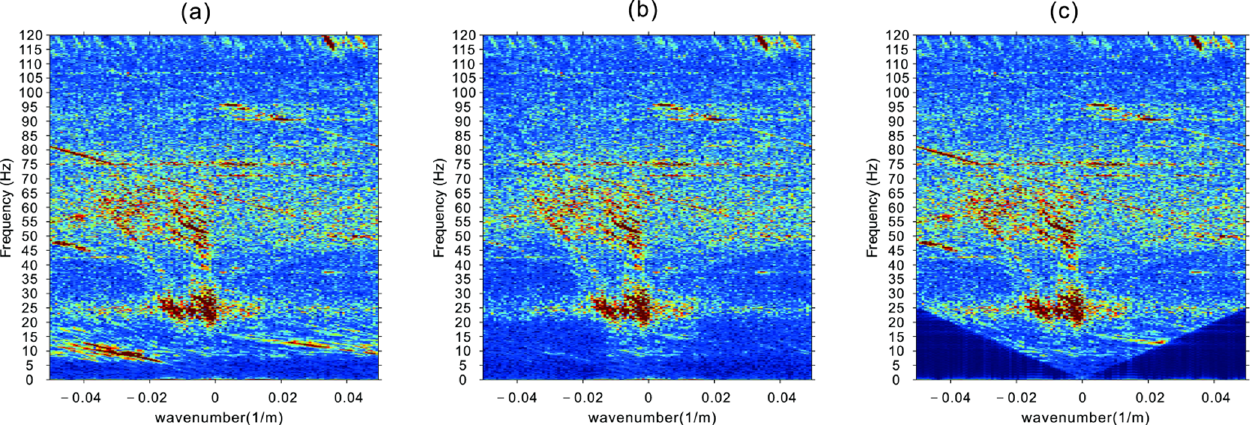
Figure 10. The results of applying f-k transform in the original seismic data and the denoised seismic data. ( a ) The original data. ( b ) The seismic data after the NSST. ( c ) The seismic data after the FK filter.